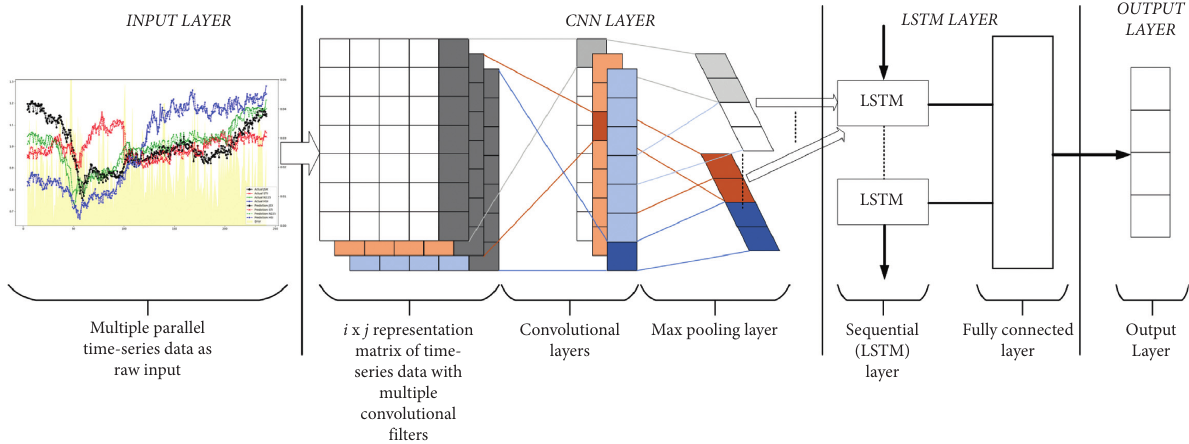
Figure 3: Architecture of the proposed multivariate CNN-LSTM for multiple parallel time-series